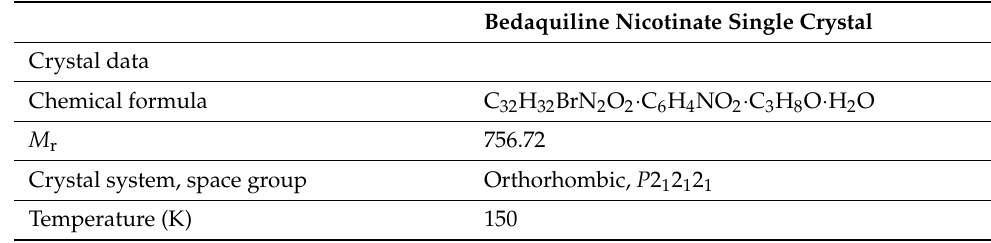
Table A2. Experimental details for bedaquiline